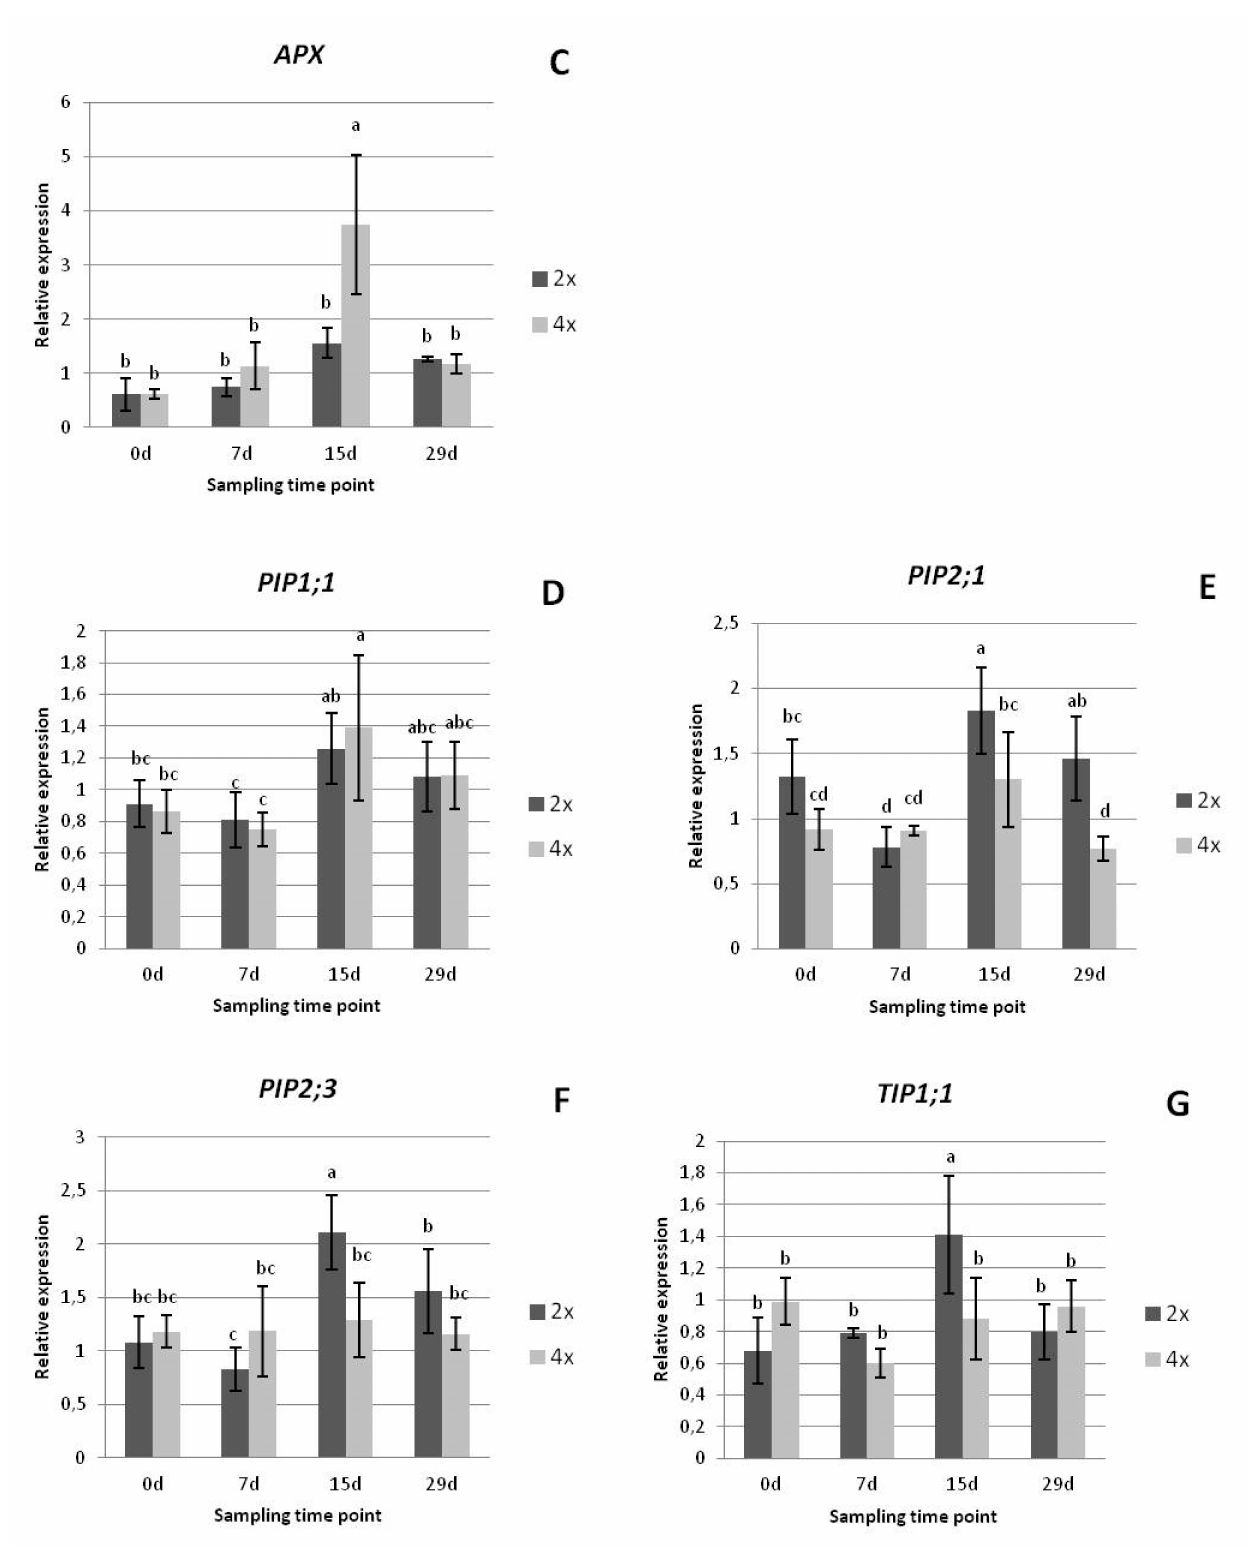
Figure 8. Relative expression analysis using qRT-PCR of the genes ( A ) CAT , ( B ) SOD , ( C ) APX , ( D ) PIP1;1 , ( E ) PIP2;1 , ( F ) PIP2;3 , ( G ) TIP1;1 in the apple cv. ‘Redchief’, diploid (2x) and tetraploid clone 4x-25 (4x), before (0 d) and 7, 15, and 29 days after inducing drought. Bars marked with the same letter do not differ significantly at p = 0.05; Duncan’s